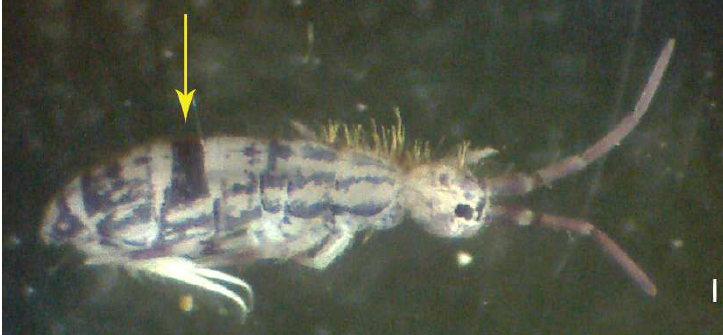
F IGURE 8. Dark disk on third abdominal segment in O. cincta (scale: 1000 µm) .